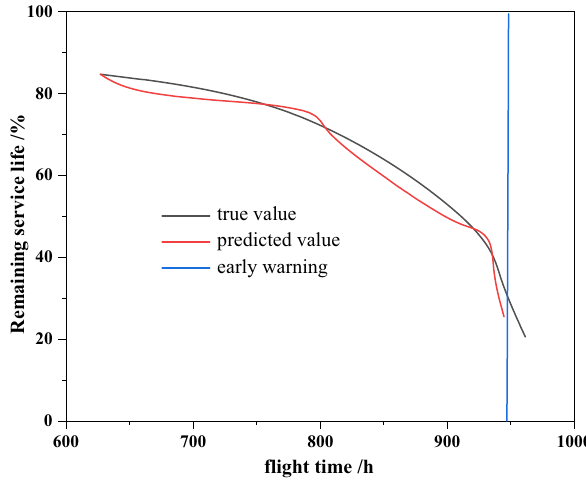
Figure 7: Comparison between predicted value and real value under external